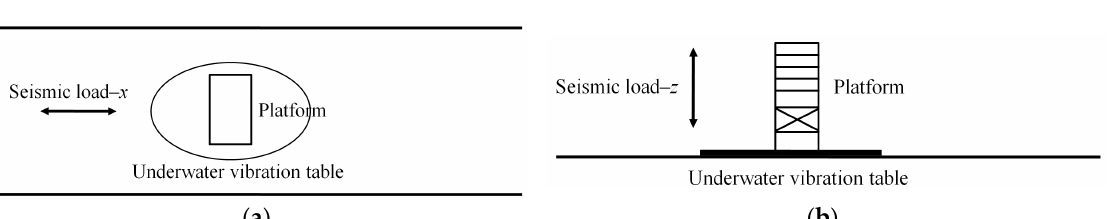
Figure 3. The experimental layout of the electrical platform model. ( a ) Top view and ( b ) side view.